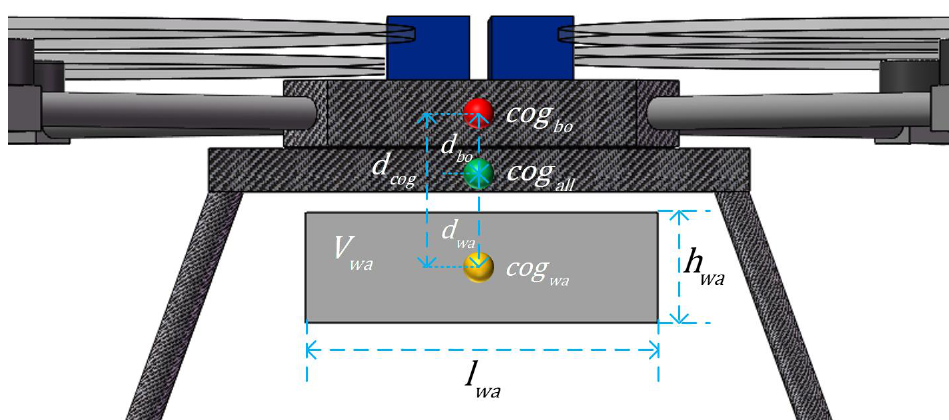
Figure 3. Model of the large-load quadrotor with water in the